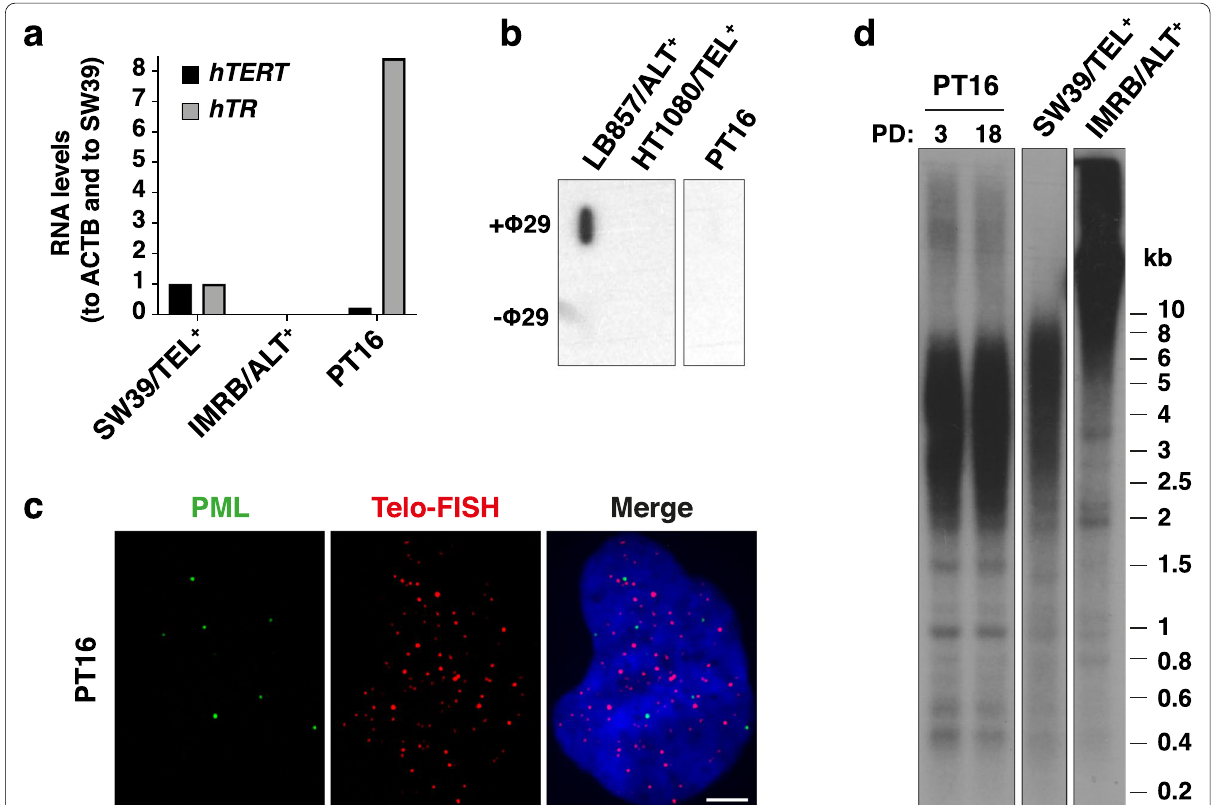
Fig. 5 Characterization of TMM in PT16-derived cell line. a hTERT (black) and hTR (grey) RNA levels, normalized to ACTB and to SW39/TEL + immortalized cell line, in PT16 cell line and IMRB/ALT + immortalized cell lines ( n Φ29) Phi29 DNA polymerase in PT16 cell line compared to LB857/ALT + and HT1080/TEL + cell lines. c Representative images of PML (IF, green) and telomeres (denaturing FISH, red) staining in PT16 cell line. Scale bar: 5 μm. d TRF analysis of telomere length of PT16 cell line at population doubling (PD) 3 or 18 compared to SW39/TEL + and IMRB/ALT +